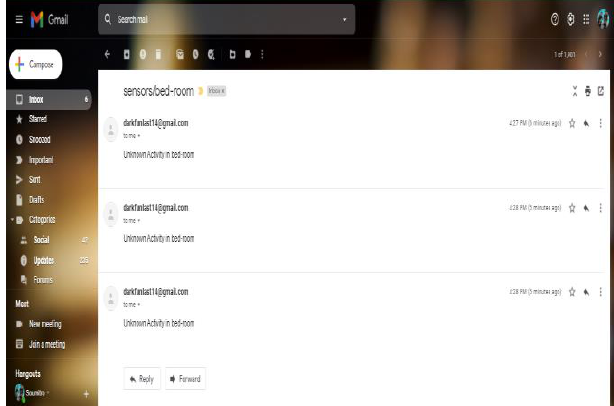
Fig.7 . House Plan Showing all devices when Lockdown Mode ON